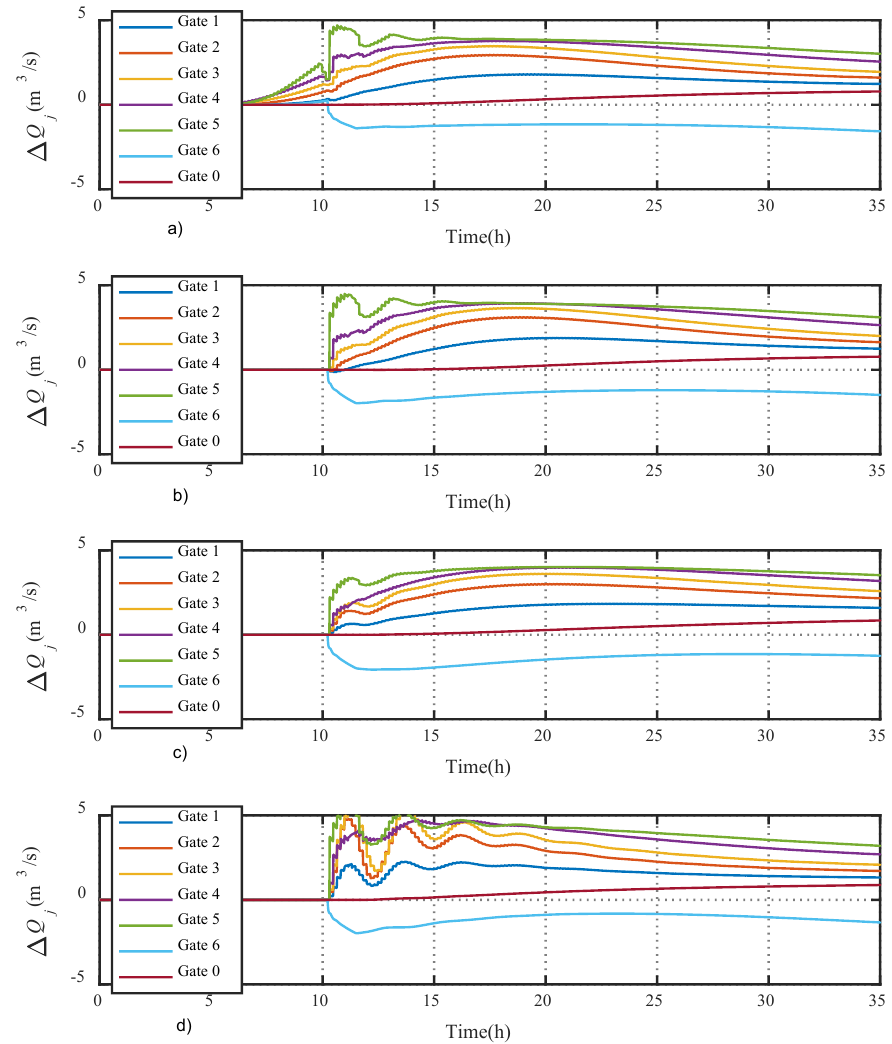
Figure 5. The simulation flow change result for scenario No. 2 with MPC-I control ( a ), MPC-I control ( b ), LQR I ( c ), and LQR II ( d ).